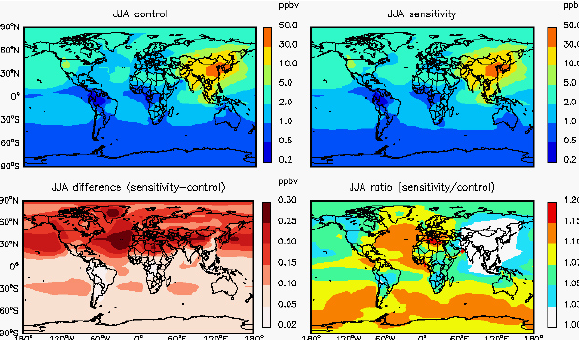
Fig. 4a. June–August average surface O 3 concentration attributable to Asian emissions and the impacts from stratospheric ozone recov- ery.